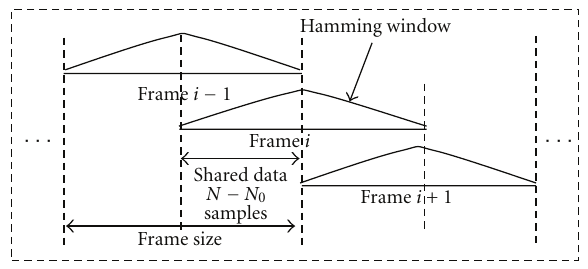
Figure 3: Hamming window technique for speech